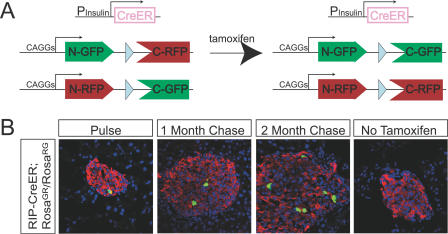
Clonal Analysis of β cells(A) Schematic for the RIP-CreER; Rosa26GR/Rosa26RG pulse–chase experiments.(B) RIP-CreER; Rosa26GR/Rosa26RG mice were pulsed with a tamoxifen injection between 4–8 wk of age. Shown here are sections of typical β cell clones (green) within 4 d of the pulse and after 1 and 2 mo of chase. β cells are identified by insulin staining (red). Original magnification, 400×.